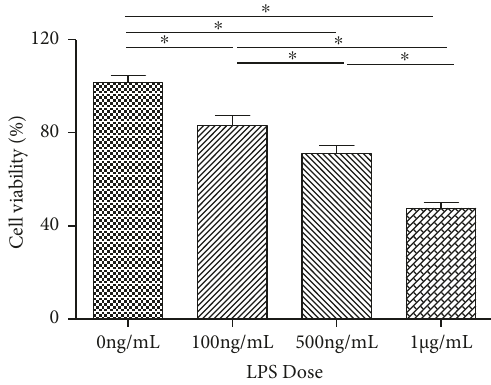
Figure 1: E ff ects of LPS doses on human pulmonary artery endothelial cell